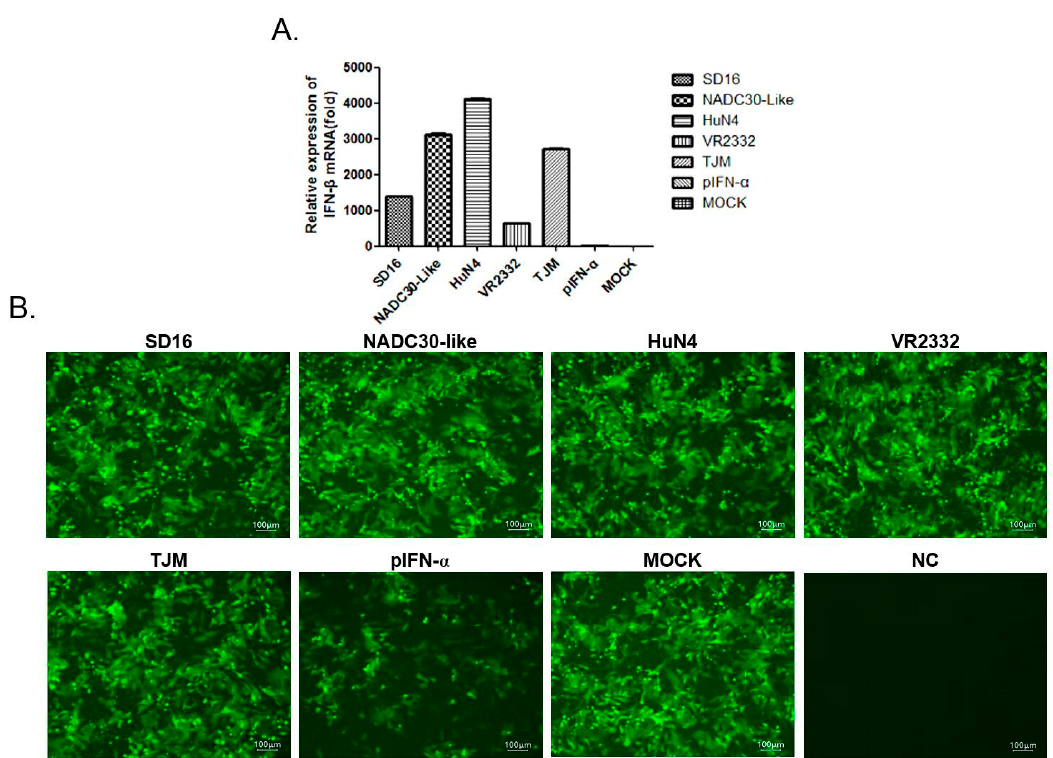
Figure 4. Expression of ISG15 in PRRSV-infected PAMs was IFNs-independent. ( A ) PAMs were infected with heterogeneous PRRSV isolates at 1 MOI for 24 h then cells were harvested for qPCR to evaluate mRNA levels of IFN- β . PAMs without PRRSV infection were included as a control. All experiments were repeated at least three times. ( B ) Cell culture supernatants from PAMs infected with heterogeneous PRRSB isolates were harvested and used to treat VERO cells. After 12 h, VERO cells treated with a cell culture supernatant from PAMs were next infected with IFNs-sensitive NDV carrying GFP as a reporter to monitor IFNs activity in PAMs supernatants. Representative images were captured 24 h after VERO cells were inoculated with NDV-GFP.